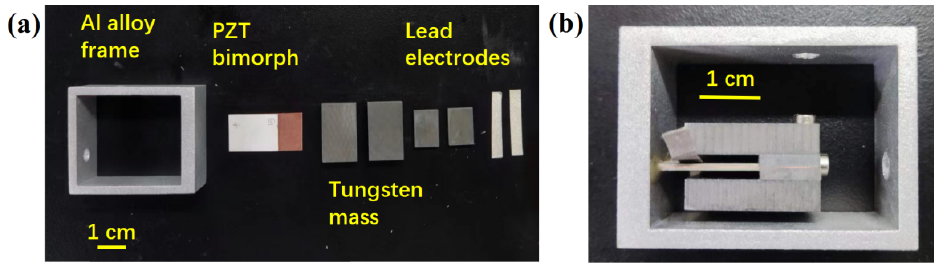
Figure 3. ( a ) PVEH assembly parts and ( b ) PVEH prototype.